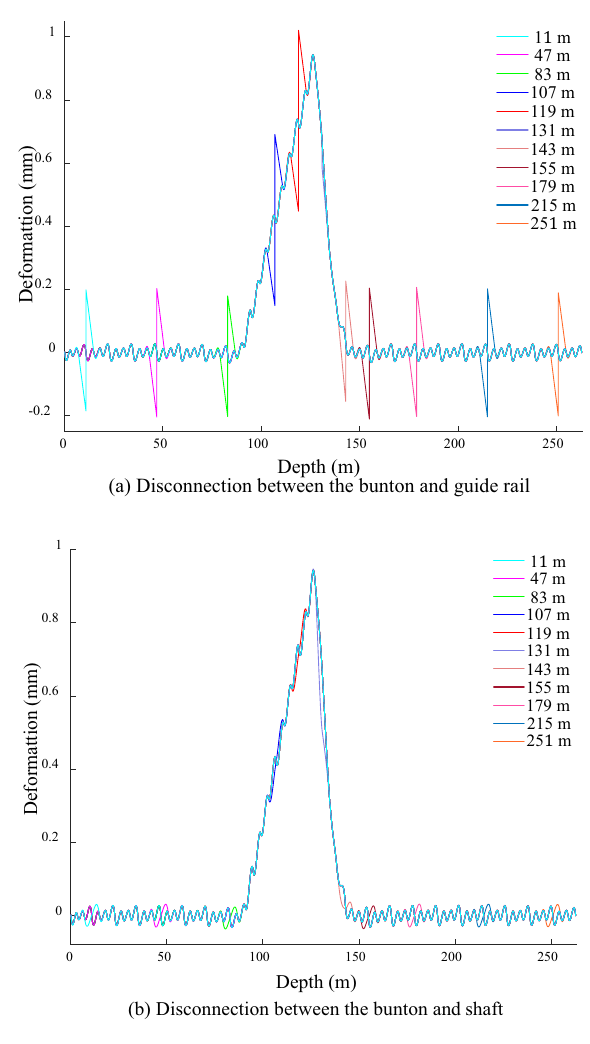
Figure 16. GRD in x -direction under dislocation when connection is